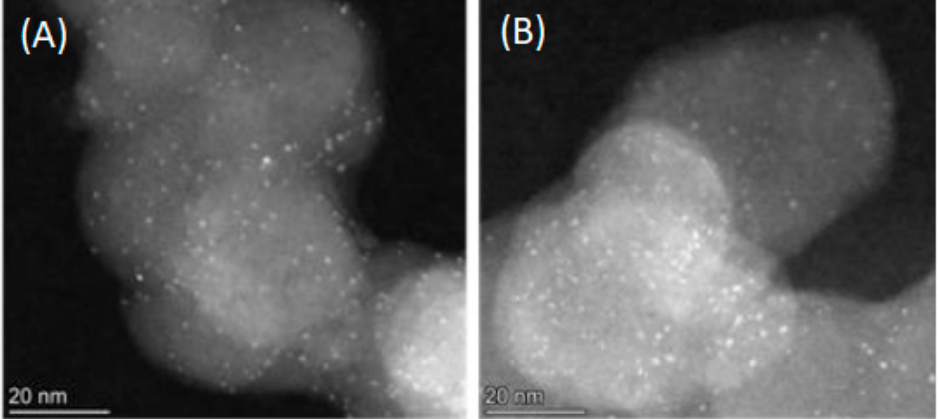
Figure 5. STEM images of ( A ) Au 25 and ( B ) Pd 1 Au 24. Adapted from Ref. [58]. Copyright by the American Chemical Society (2020).